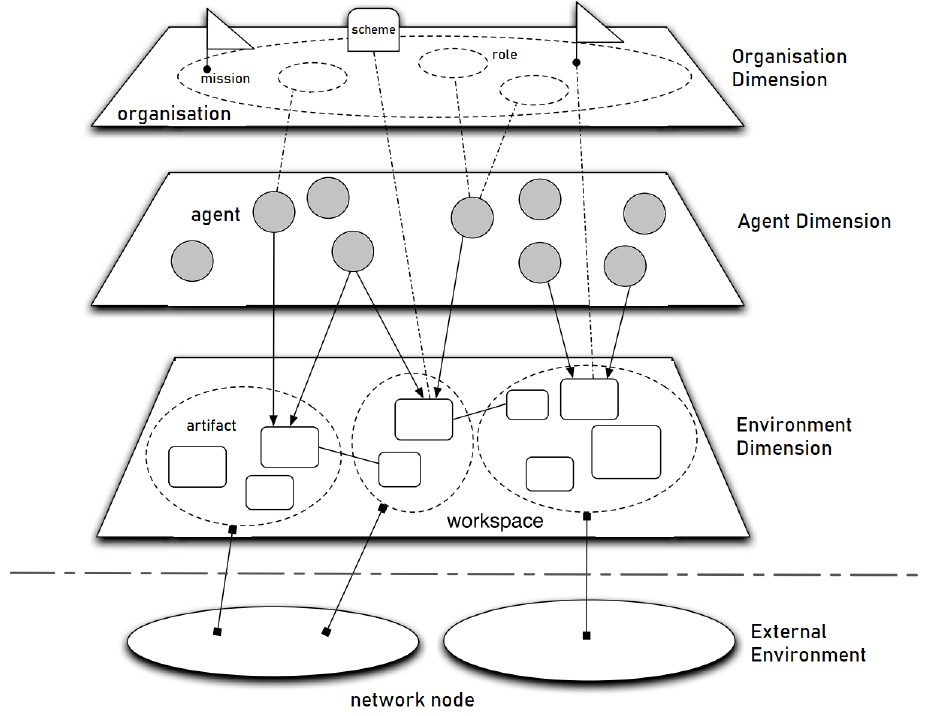
Figure 11. JaCaMo main vision, adapted from [44] with permission from